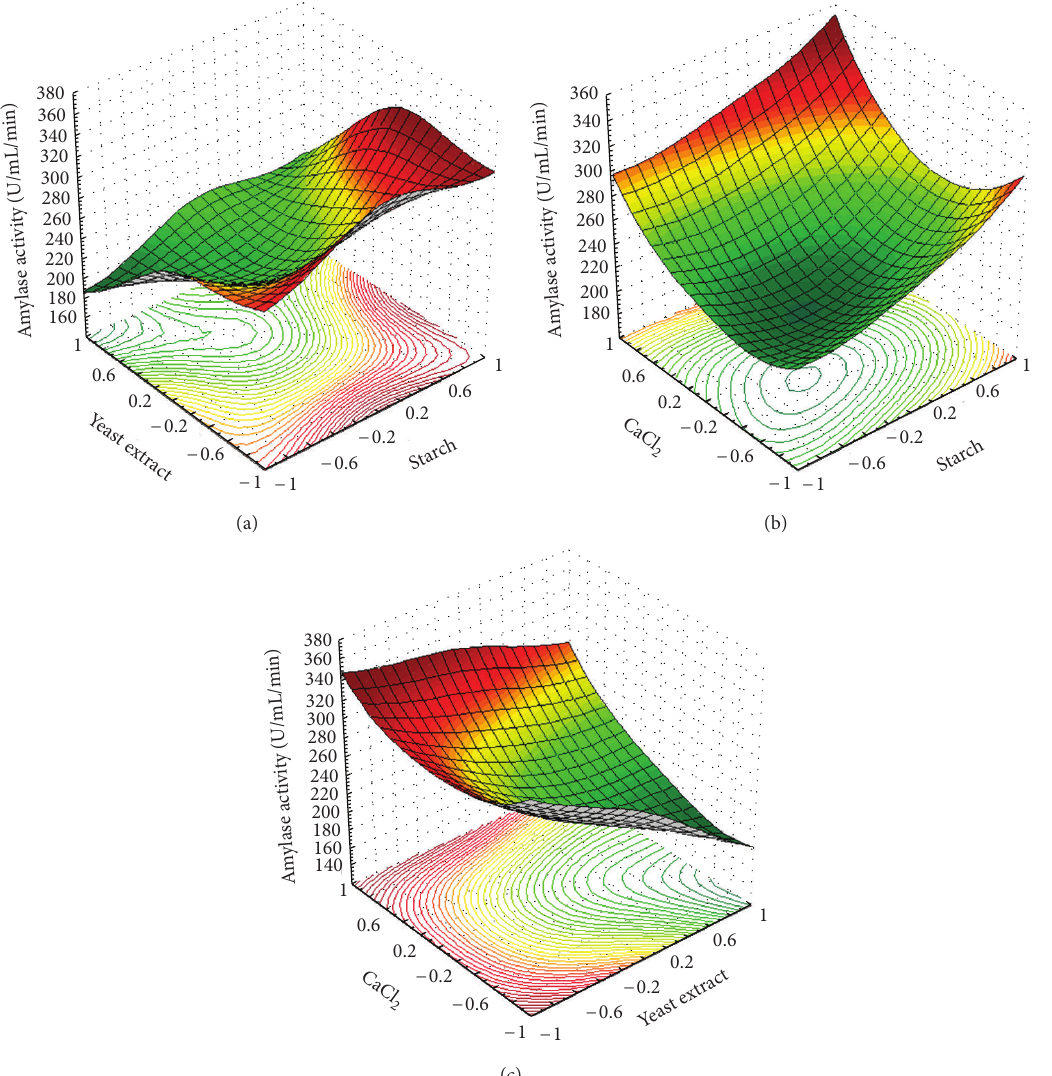
F 2: e response surface of and starch and (c), yeast extract and CaCl